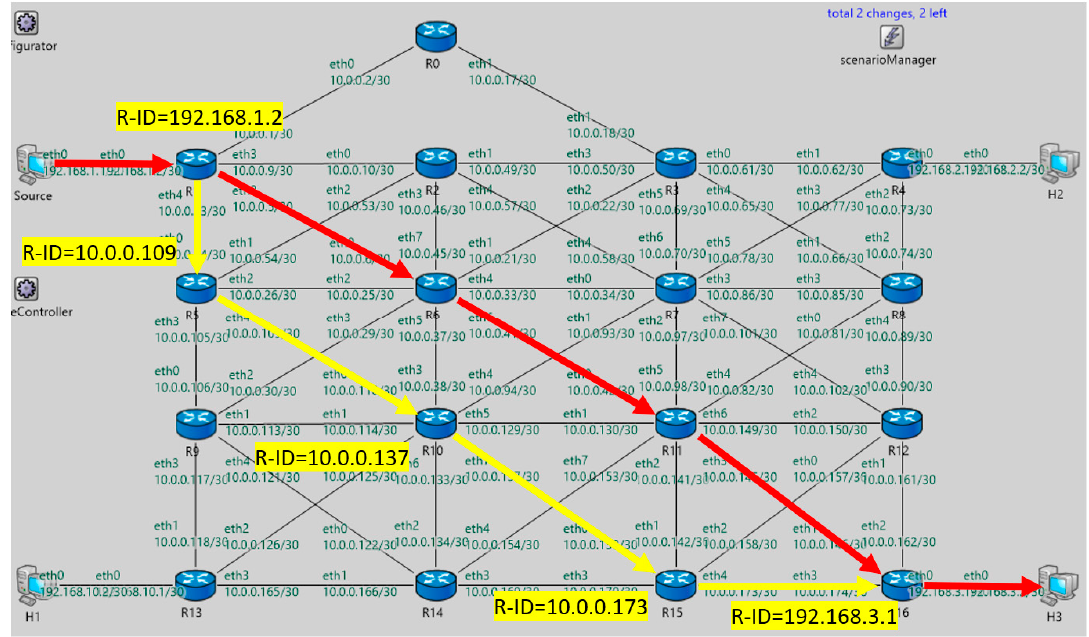
Figure 13. Visual output from the OMNeT++ simulation.